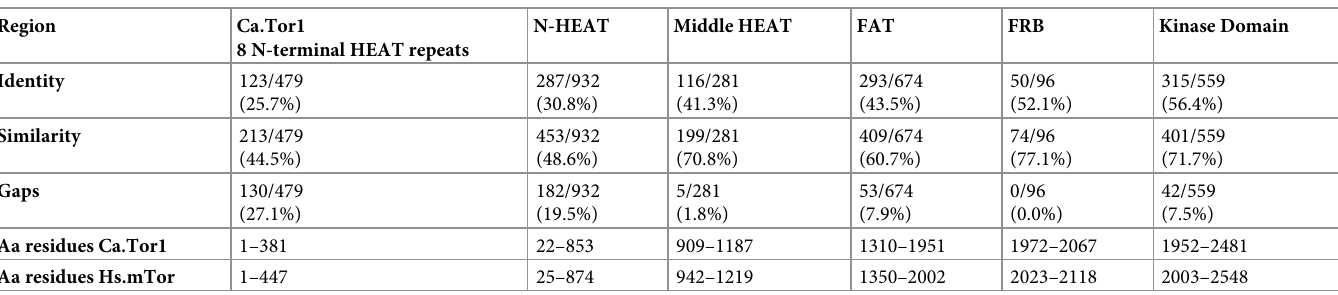
Table 1. Sequence alignments of C . albicans and human Tor kinases.